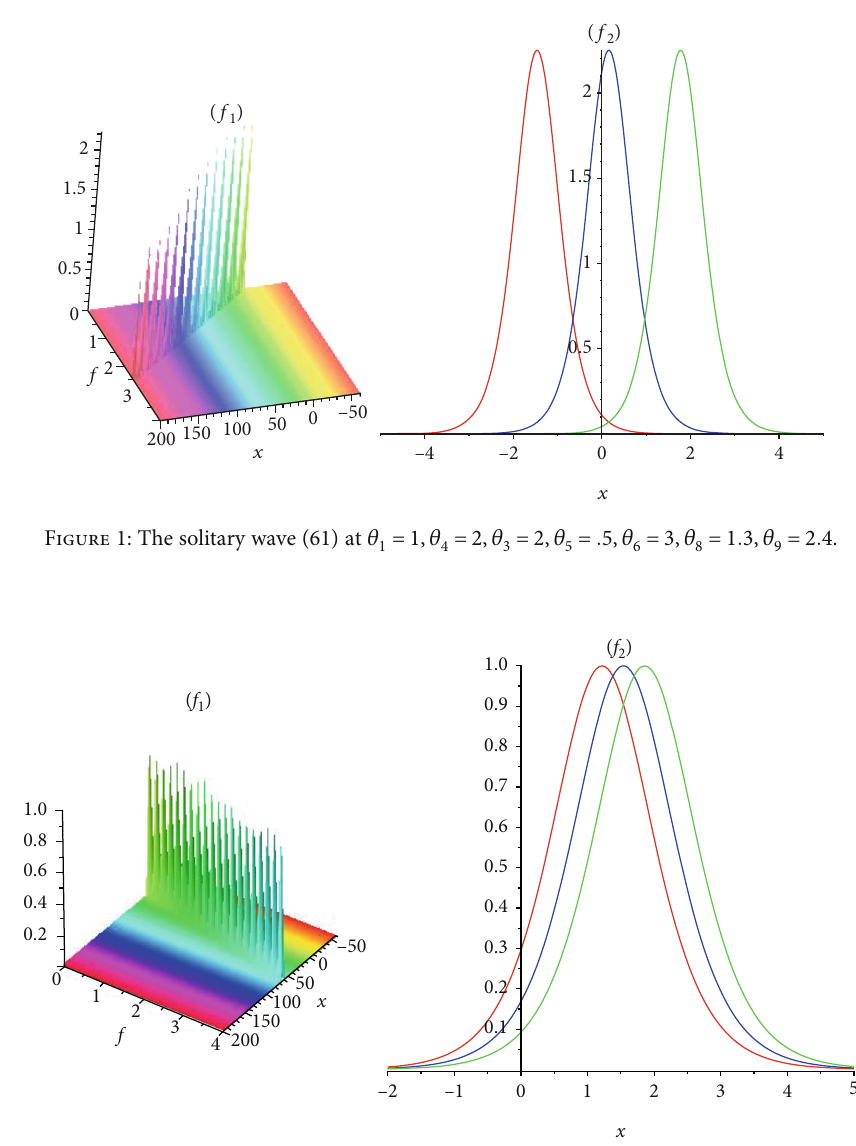
Figure 2: The solitary wave (63) at θ